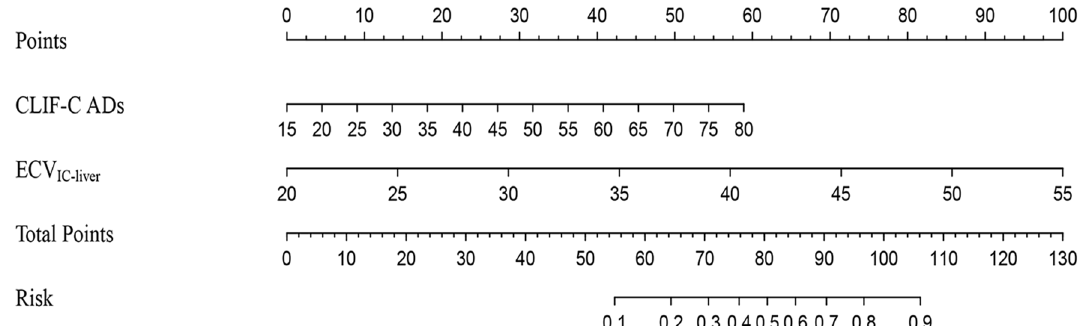
Fig. 3 The nomogram for predicting the occurrence of ACLF within 90 days. CLIF-C ADs, chronic liver failure consortium-acute decompensation score; ECV IC-liver, extracellular liver volume; ACLF, acute-on-chronic liver failure